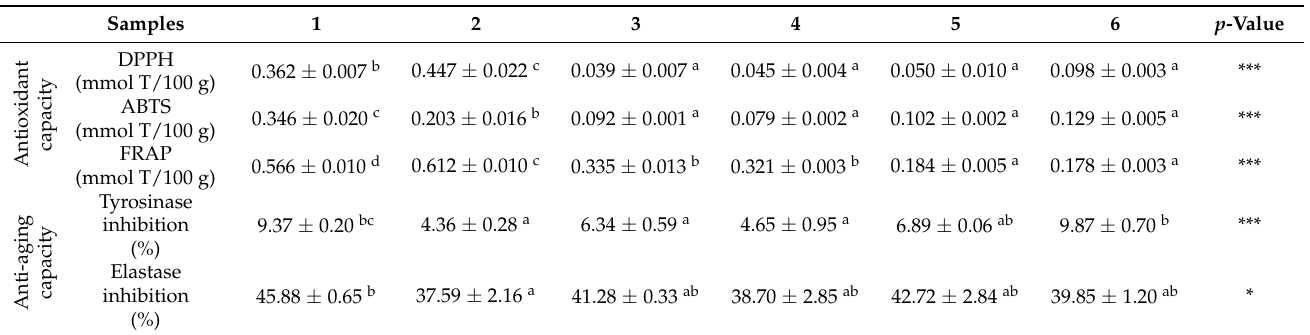
Table 3. Determination of antioxidant capacity [DPPH, ABTS, and FRAP methods (mmol T/100 g)] and anti-aging capacity (%) of honey